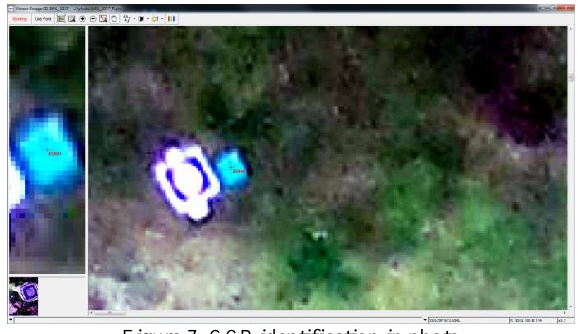
Figure 7. GCP identification in